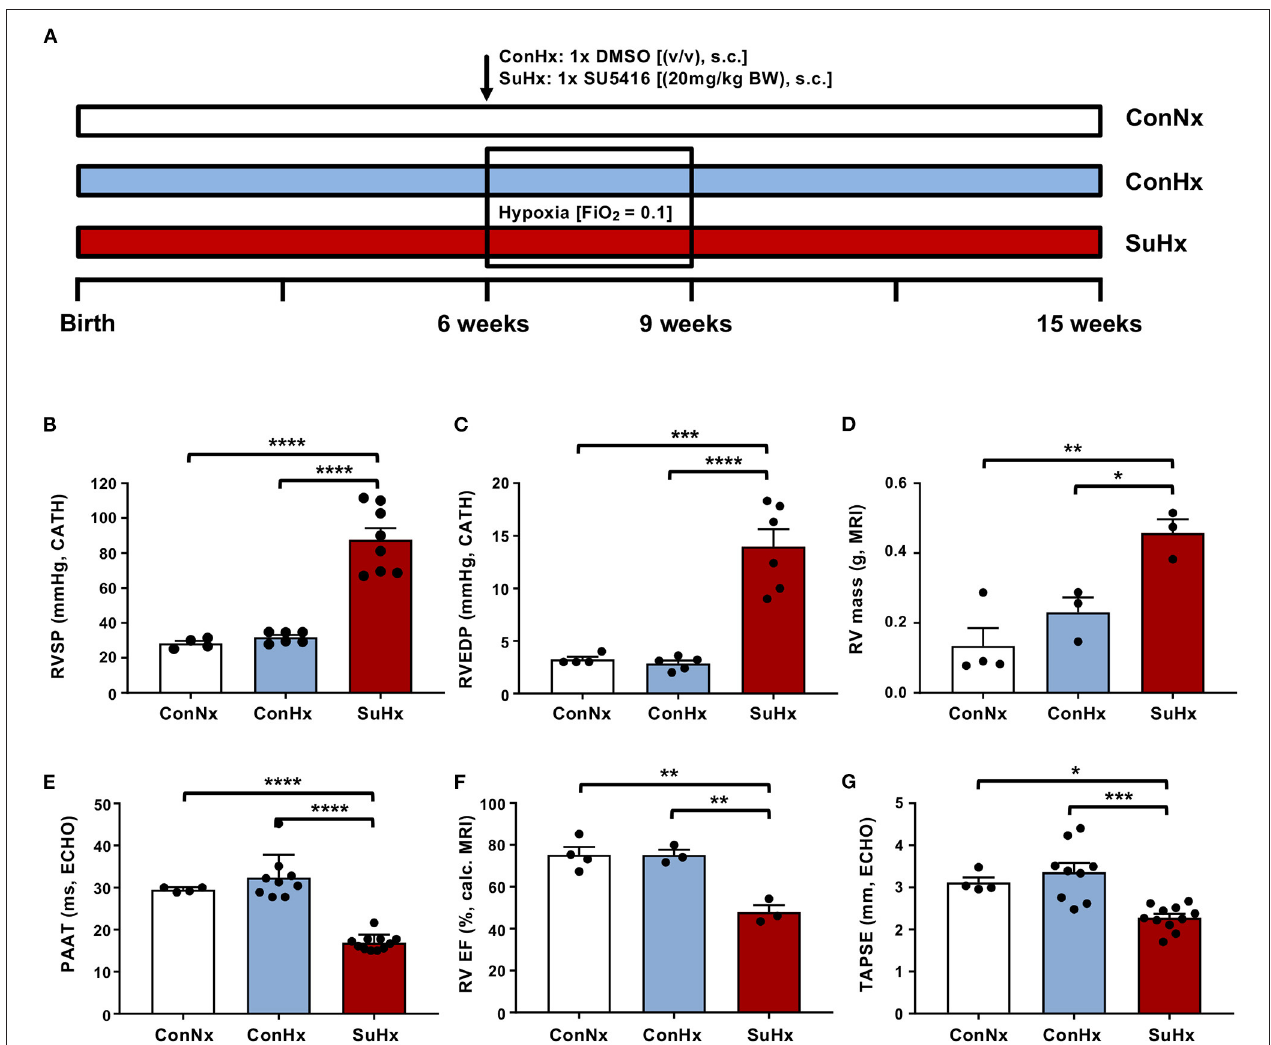
FIGURE 1 | The SU5416/hypoxia model leads to severe PAH in rats. (A) Experimental setup. Six- to eight-week-old male Sprague Dawley rats were purchased from Charles River and divided into three different treatment groups: (i) Normoxia (ConNx), (ii) Hypoxia (ConHx) [injected once s.c. with vehicle (DMSO), then exposed to chronic hypoxia (FiO 2 0.1) for 3 weeks, followed by a 6-week period in room air (FiO 2 0.21)], (iii) SU5416/hypoxia (SuHx) [injected with the VEGFR2 inhibitor SU5416 (Sigma), 20 mg/kg per dose s.c. dissolved in DMSO and subsequently exposed to chronic hypoxia (3 weeks), followed by 6 weeks of room air]. (B–D) Right ventricular systolic pressure (RVSP), right ventricular end diastolic pressure (RVEDP), both measured by heart catheterization, and right ventricular (RV) mass, measured by MRI of analyzed rats. (E–G) Pulmonary artery acceleration time (PAAT), measured by echocardiography (ECHO), right ventricular ejection fraction (RV EF), calculated from MRI data and tricuspid annular peak systolic excursion (TAPSE), measured by ECHO. Means ± SEM, ConNx n = 13, ConHx n = 12, SuHx n = 7, ANOVA-Bonferroni post-hoc test, * p < 0.05, ** p < 0.01, *** p < 0.001, **** p <